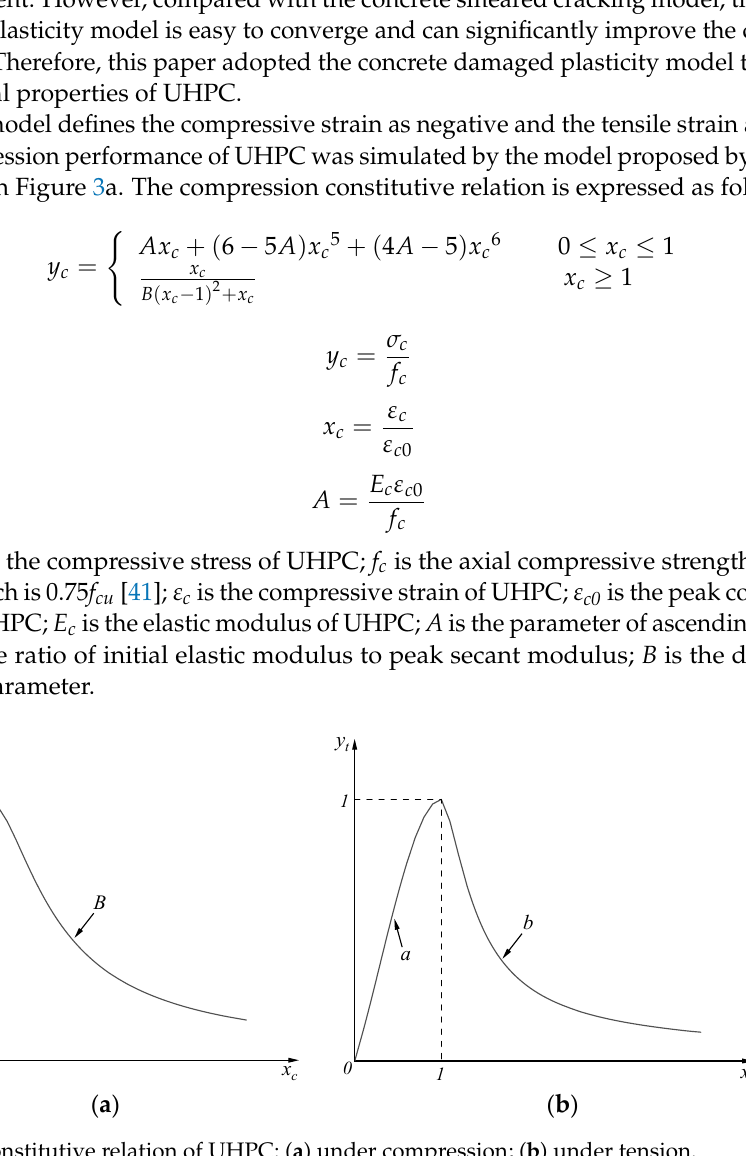
Figure 3. Constitutive relation of UHPC: ( a ) under compression; ( b ) under tension.